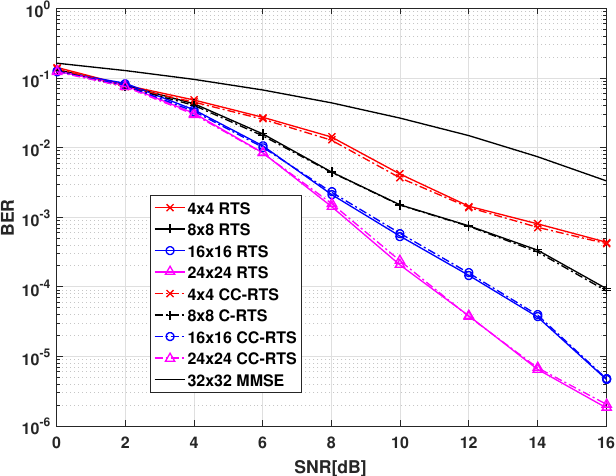
Figure 3. Bit error rate performance of CC-RTS taking MMSE solution as the initial vector for 4 × 4, 8 × 8, 16 × 16, 24 × 24 MIMO system with Rayleigh channel , QPSK modulation, d th =